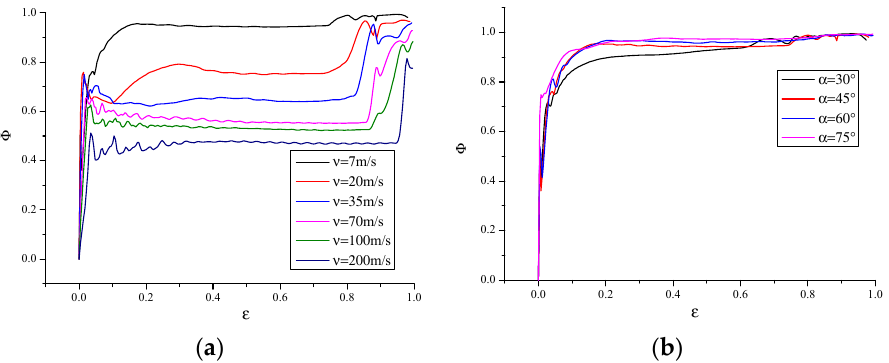
Figure 15. Relationship between energy distribution coefficient and strain. ( a ) Φ (internal energy distribution coefficient) with different velocities. ( b ) Φ (internal energy distribution coefficient) with different cell angles).